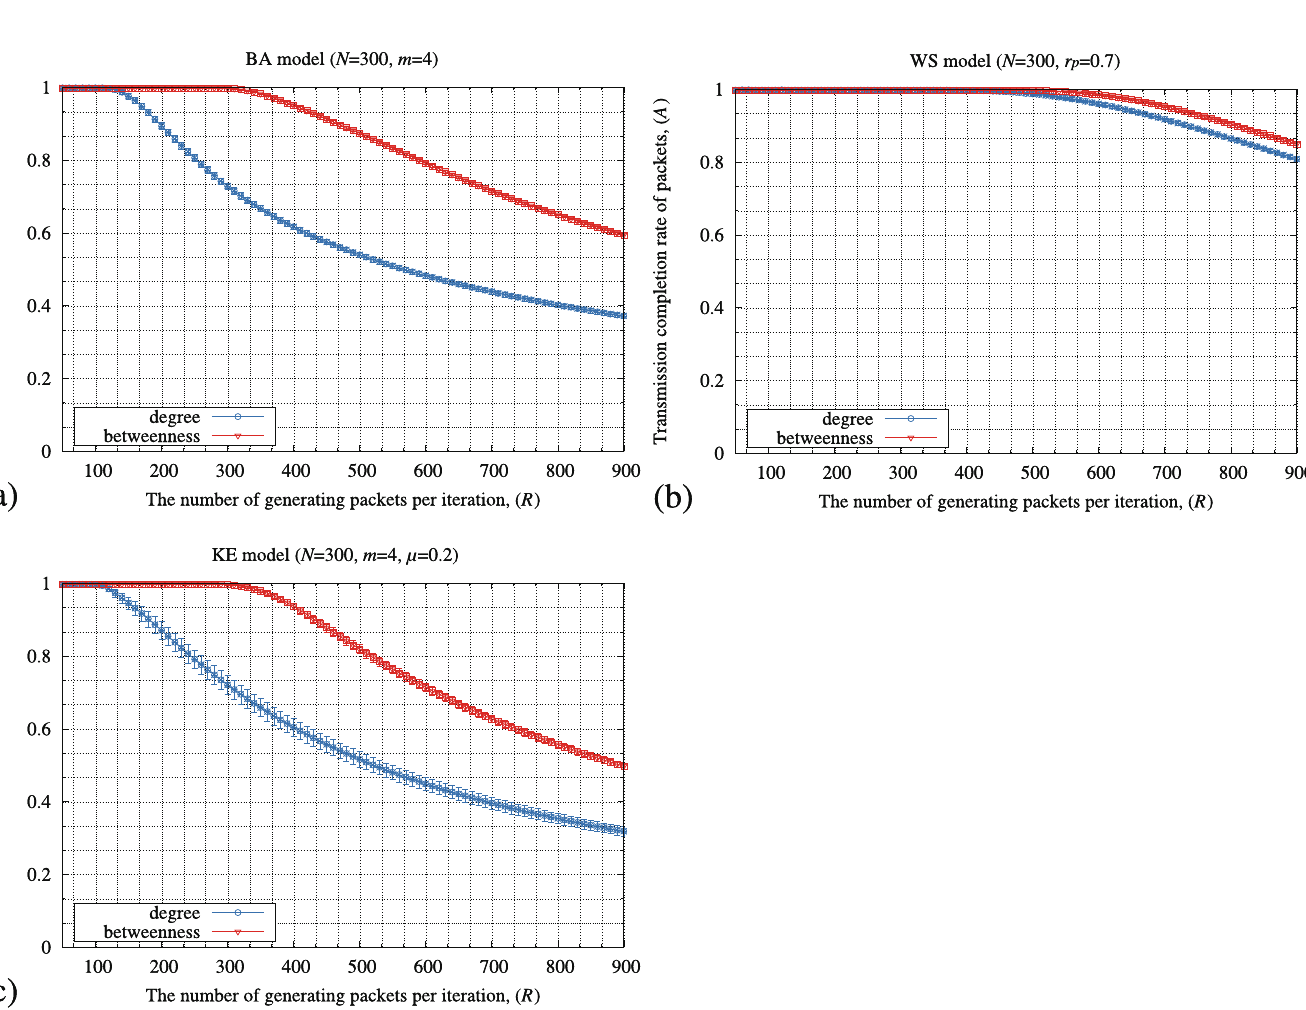
Fig 2. Relationship between the number of generating packets at each iteration ( R ) of the SP method and the transmission completion rate of packets ( A ) defined by Eq (7) for the (a) BA, (b) WS, and (c) KE models. In these figures, the “degree” and “betweenness” in the figure legends express that the packet transmission and storage performance are composed of the node degree and node betweenness centralities, respectively. In these figures, the standard deviation of each method is plotted as error bars.